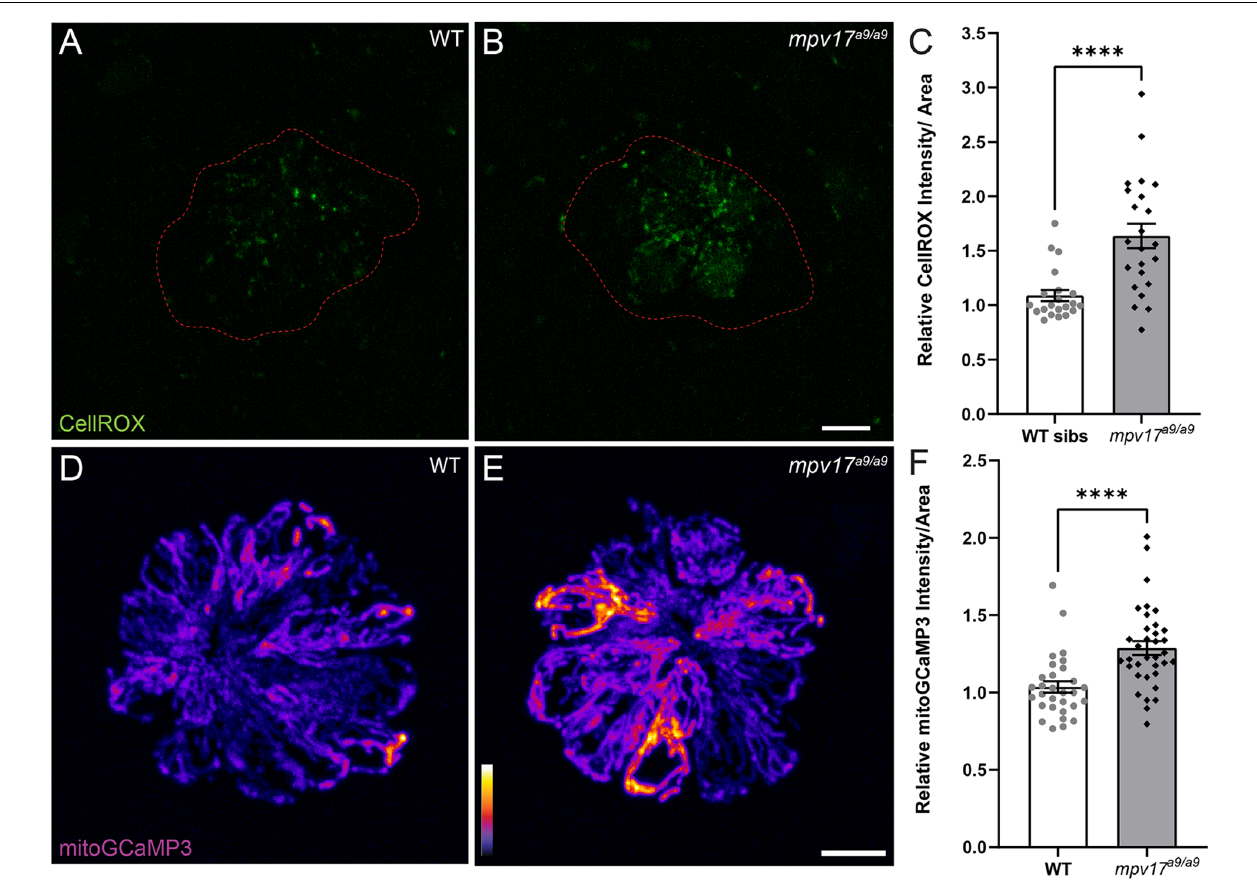
FIGURE 1 | Mitochondrial homeostasis in WT and mpv17 a9/a9 neuromasts. (A,B) Maximum-intensity projections of confocal images showing CellROX Green staining in WT siblings (A) and mpv17 a9/a9 (B) neuromasts. Neuromast boundaries were delineated based on DIC images (not shown). (C) Mean CellROX intensity is elevated in mpv17 a9/a9 neuromasts ( ∗∗∗∗ P < 0.0001). n = 21–23 neuromasts; N = 2 experimental trials. (D,E) Maximum-intensity projections of confocal images showing mitoGCaMP3 fluorescence in WT (D) and mpv17 a9/a9 (E) neuromasts. (F) Mean mitoGCaMP3 intensity is increased in mpv17 a9/a9 neuromasts ( ∗∗∗∗ P < 0.0001). n = 30–35 neuromasts (L3, L4, and L5); N = 2 experimental trials. Scale bars: 5 µ m. Error bars: